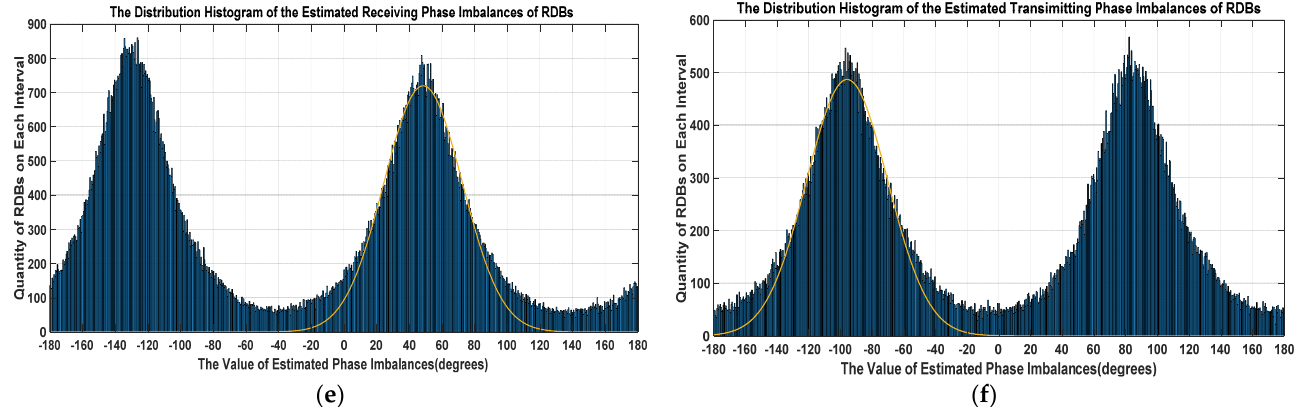
Figure 5. The phase imbalance estimation results of the two estimation methods in a typical scene of GF-3 quad-pol data (Product ID: GF3_MYN_QPSI_002054_E113.3_N22.5_20161230_L1A_AHV_L10002080826 ). ( a ) The Pauli polarization pseudo-color image of this scene. The yellow cross marks represent the extracted RDB targets, while the white box represents the forest areas used for the quad-pol estimation method, and the blue box corresponds to the areas in image ( b ). ( b ) The distribution of RDBs in the local urban area of this scene, where the yellow circle marks correspond to the peak on the right in figure ( e ), and the blue triangle marks correspond to the peak on the left in figure ( e ). ( c ) The results of the receiving phase imbalance estimation obtained by the quad-pol method based on the forest area in figure ( a ). ( d ) The results of the transmitting phase imbalance estimation obtained by the quad-pol method based on the forest area in figure ( a ). ( e ) The distribution histogram of the receiving phase imbalances obtained from the extracted RDBs from the whole scene. ( f ) The distribution histogram of the transmitting phase imbalances obtained from the extracted RDBs from the whole scene.